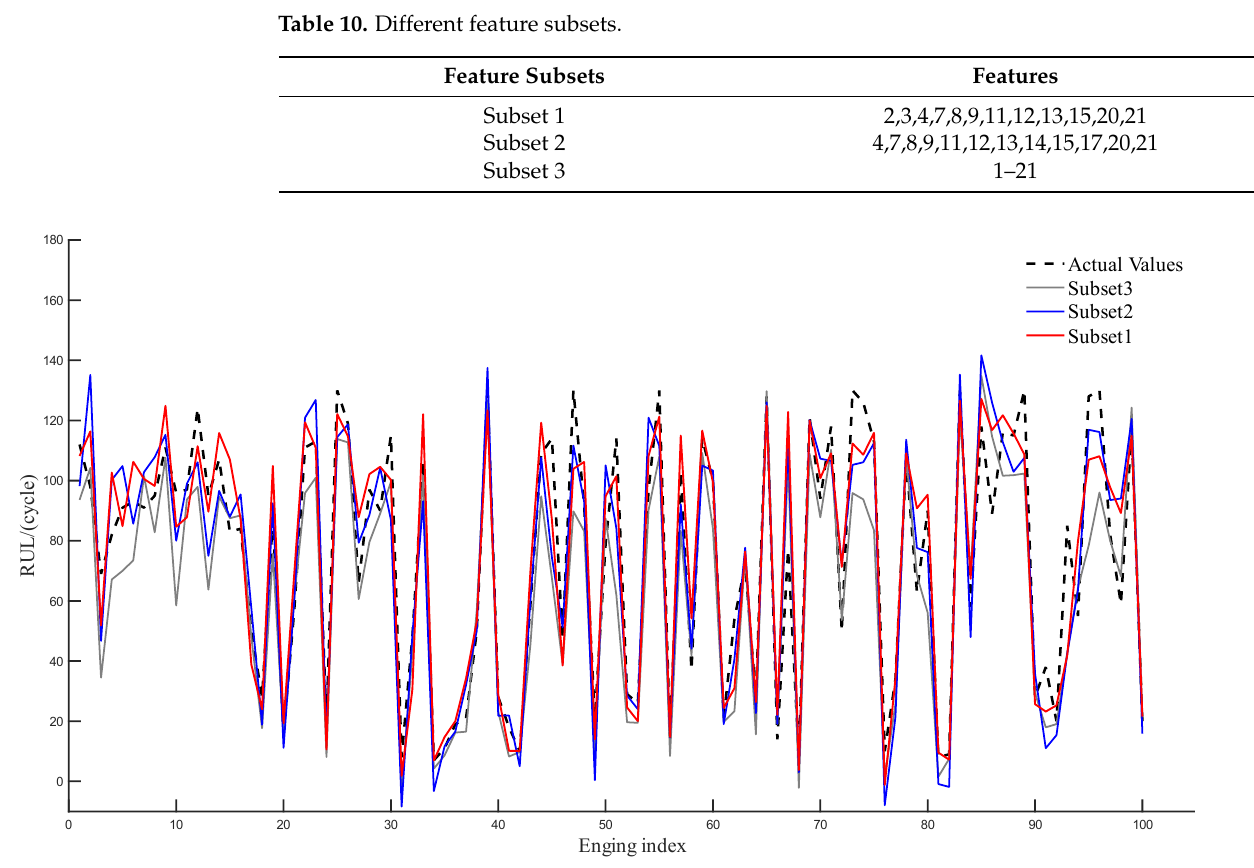
Figure 14. RUL prediction of different feature subsets.